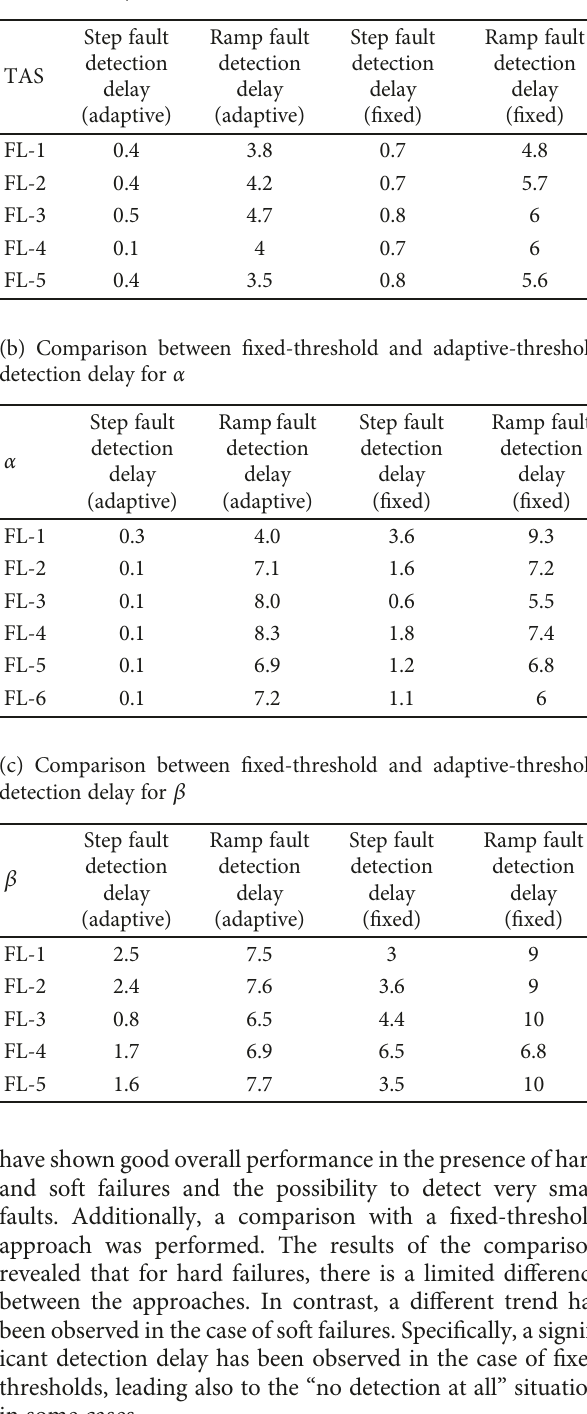
(a) Comparison between fi xed-threshold and adaptive-threshold